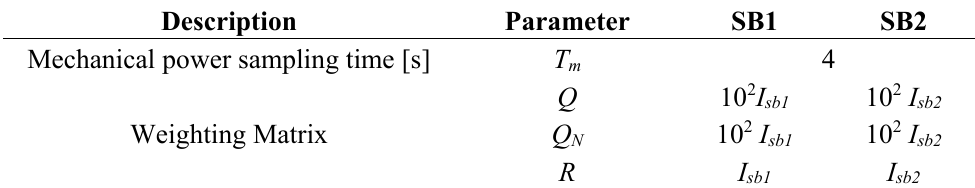
Table 5. Data and Parameters for Bulk-Area Partitioning in BA1.